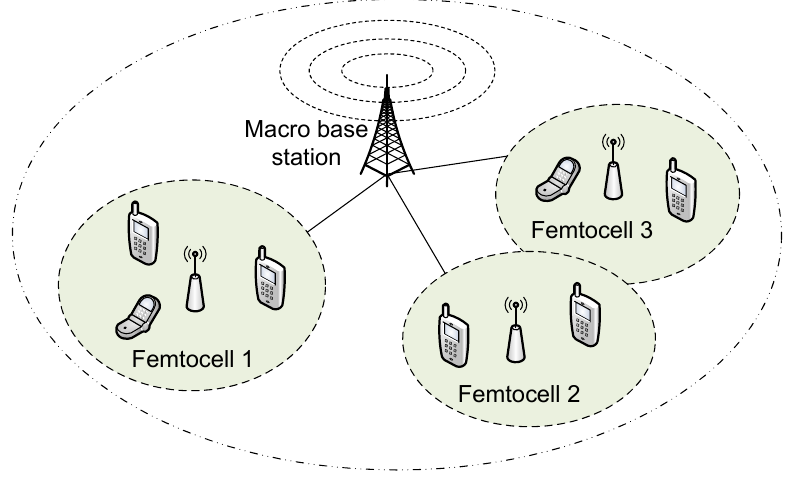
Figure 1. The femtocell network